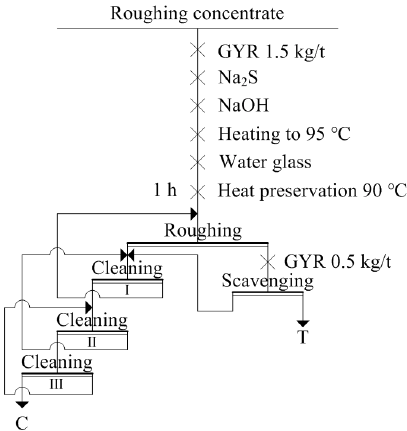
Figure 2. Closed-circuit flowsheet of scheelite heating flotation.